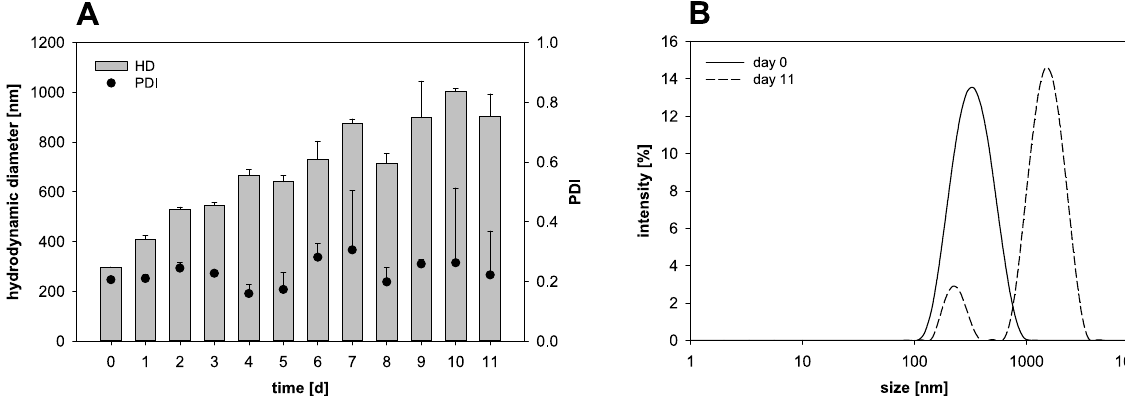
Figure 1. Nanocapsule stability over 11 days of storage (4 ◦ C) in suspension: ( A ) Variation of the hydrodynamic diameter (HD) and the polydispersity index (PDI) (mean ± SD; n = 3) and ( B ) intensity weighted size distribution on day 0 and day